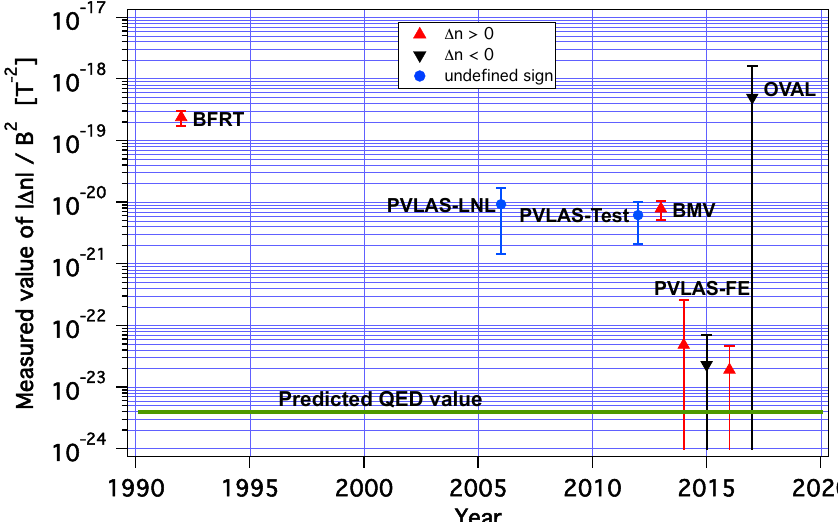
Figure 17. Historical time evolution of the measurement of vacuum magnetic birefringence nor- malized to B 2 ext . Error bars correspond to one σ . The values derive from the following references: BFRT [40]; PVLAS-LNL [44,45], PVLAS-Test [61], BMV [62], PVLAS-FE [59,67], OVAL